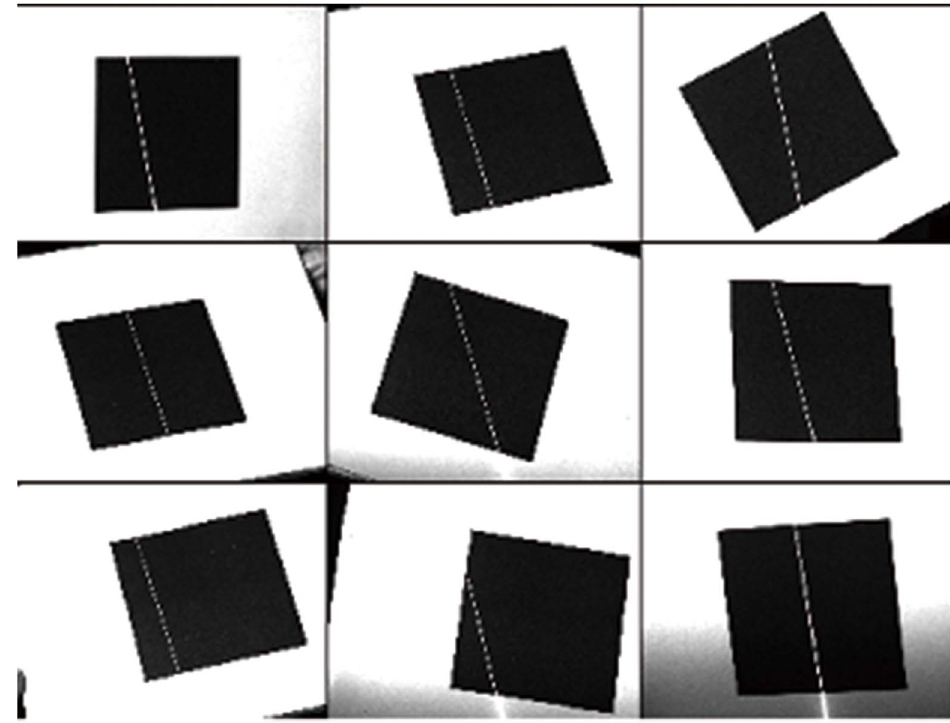
Figure 12. Calibration patterns for projector model. doi:10.1371/journal.pone.0106911.g012 PLOS ONE |